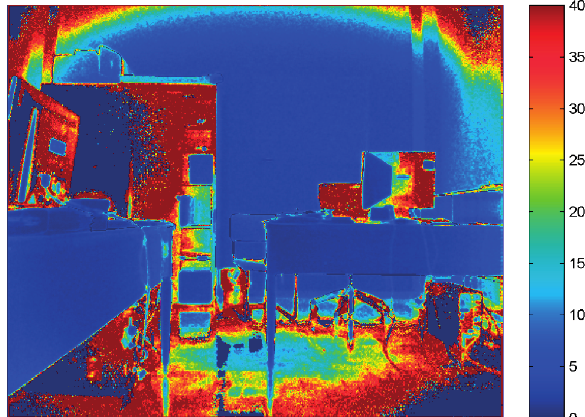
Figure 6. Standard deviation (mm) computed for each corresponding pixel of the raw depth data acquired by Kinect 1.0 IR camera.